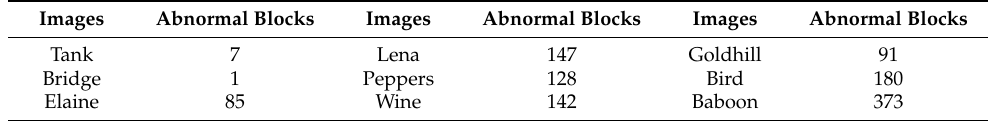
Table 2. Number of abnormal blocks detected by side-match